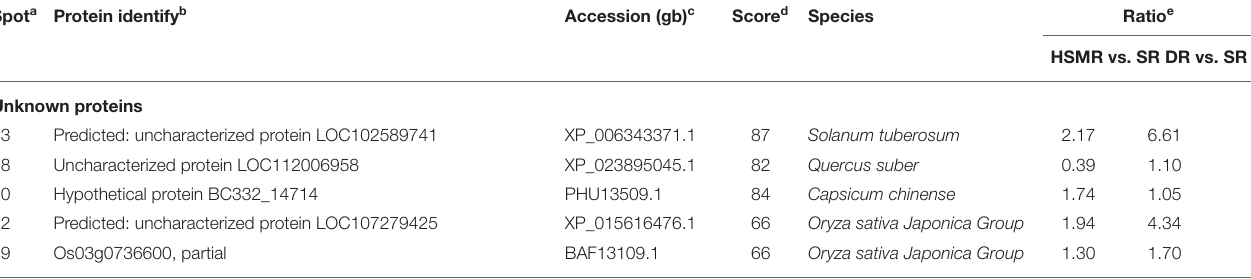
translation (23.26%), stress response proteins (18.6%), lipid metabolism (11.63%), others (11.63%), and unknown proteins (11.63%) ( Figure 5B